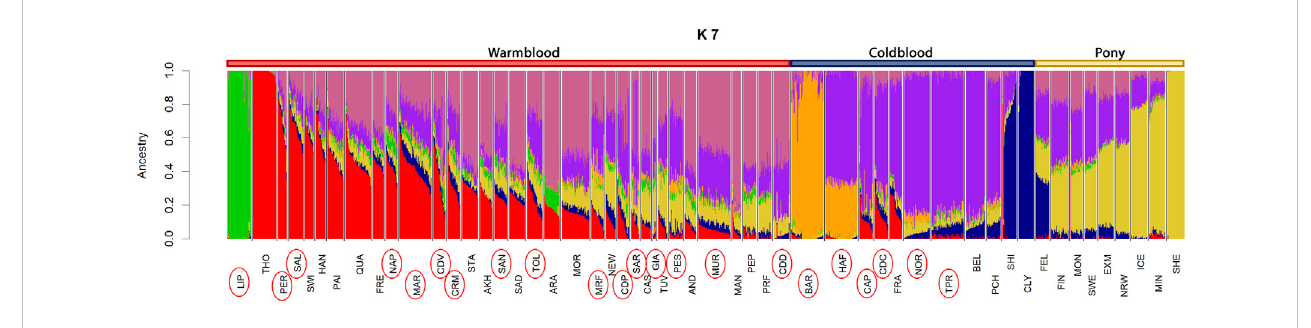
FIGURE 4 Admixture plotatK= 7from theInternational dataset. On thetop ofthegraph, colorbars indicate groupsof breedtypes: warmblood breedsaremarked in red, coldblood breeds in blue and ponies in yellow. Full list of used acronyms is available in Supplementary Table